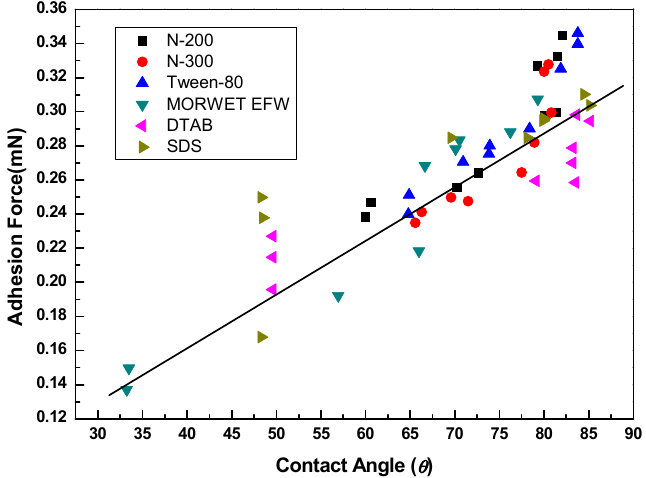
Figure 9. Relationship between the adhesion force (mN) and contact angle ( θ ) of aqueous surfactant solutions on tea leaf surfaces.